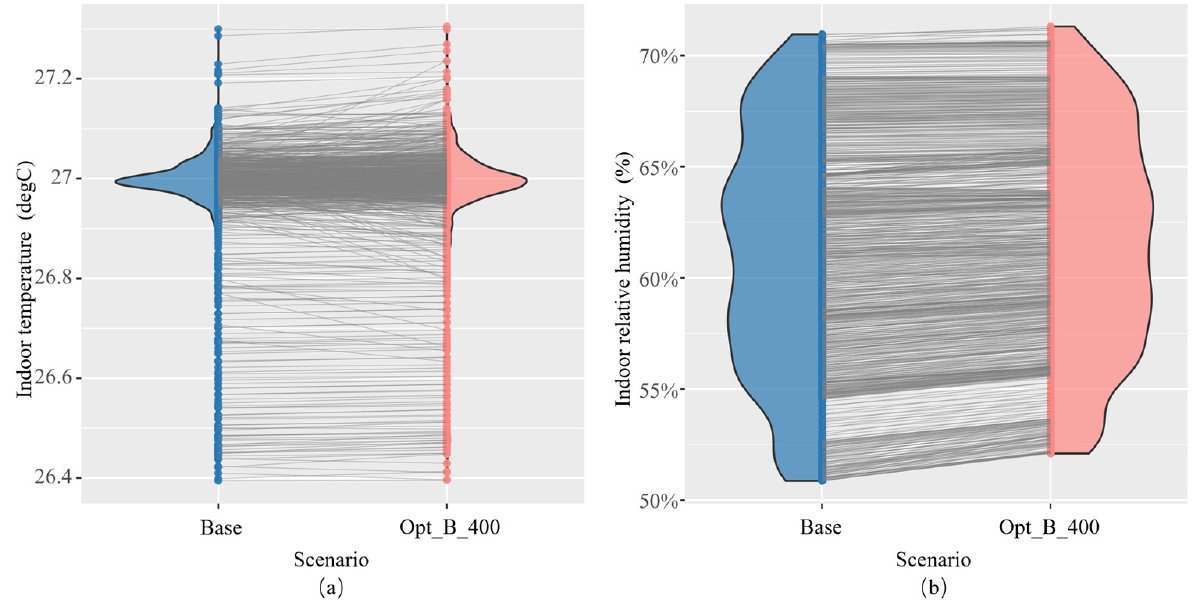
Figure 9. ( a ) Comparison of room temperature under two strategies; ( b ) Comparison of indoor relative humidity under two strategies. (In the figure, red represents the use of Opt_B_400 scheme, blue represents the use of Base scheme).